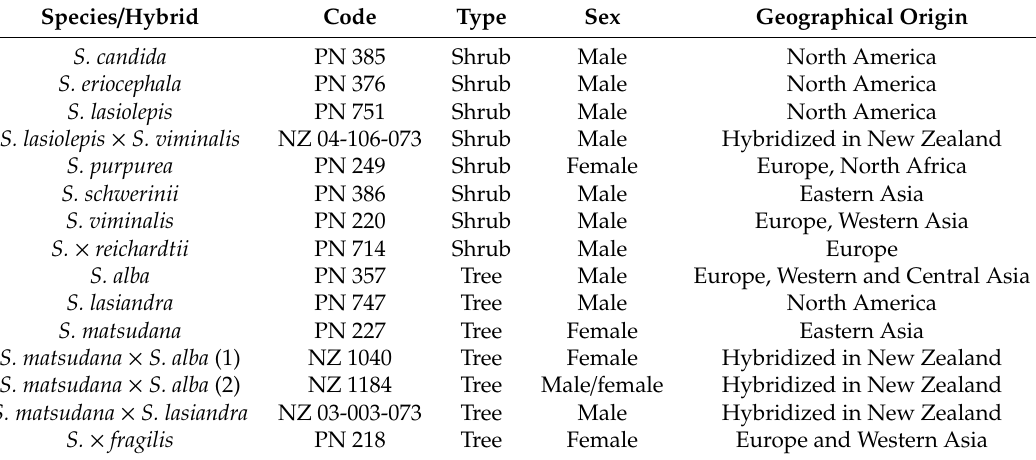
Table 1. Willow species and hybrids used in this